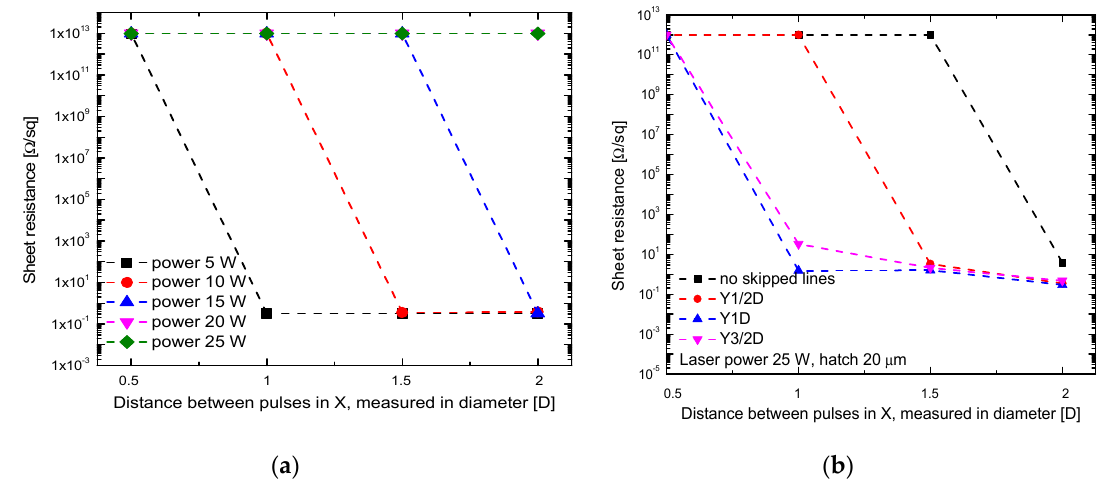
Figure 7. Dependence of the sheet resistance of deposited copper layer on the distance between pulses in the first run in the X direction (expressed in parts of diameter (D)) for various laser average power settings (a) and the different distance between pulses in the Y direction (b).